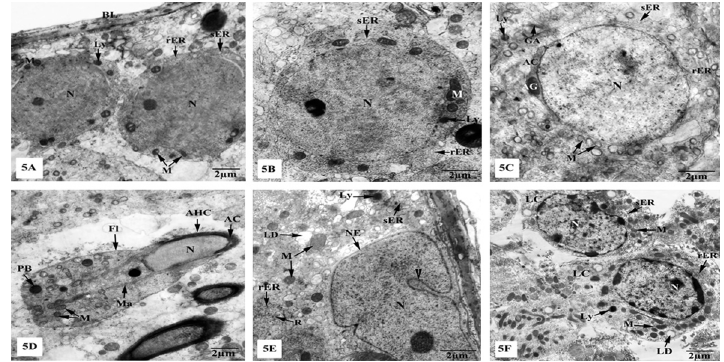
Figure 5. Electron micrographs of the testes of control and sham groups showing ( A ) spermatogonia resting upon a thin basal lamina (BL) and possess nuclei (N), mitochondria (M), lysosomes (Ly), rough endoplasmic reticulum (rER), and smooth endoplasmic reticulum (sER); ( B ) primary spermatocyte with N, M, Ly, sER, and rER; ( C ) rounded spermatid with vacuolated M, Golgi apparatus (GA), Ly, rER, and sER, as well as acrosomal granule (AG) and acrosomal cap (AC), which cover the nucleus; ( D ) elongated spermatid showing N covered with AC forming the acrosomal head cap (AHC), the manchette (Ma), and the fl agellum (Fl), with M and phagosomal bodies (PB); ( E ) Sertoli cell appeared with irregular N, enclosed within a nuclear envelope (NE) with a deep indentation ( c ), and its cytoplasm containing M, Ly, lipid droplets (LD), free ribosomes (R), sER, and rER; ( F ) interstitial tissue revealing Leydig cells (LC) with numerous M, sER, rER, Ly, LD, and N. Scale bar 2 m